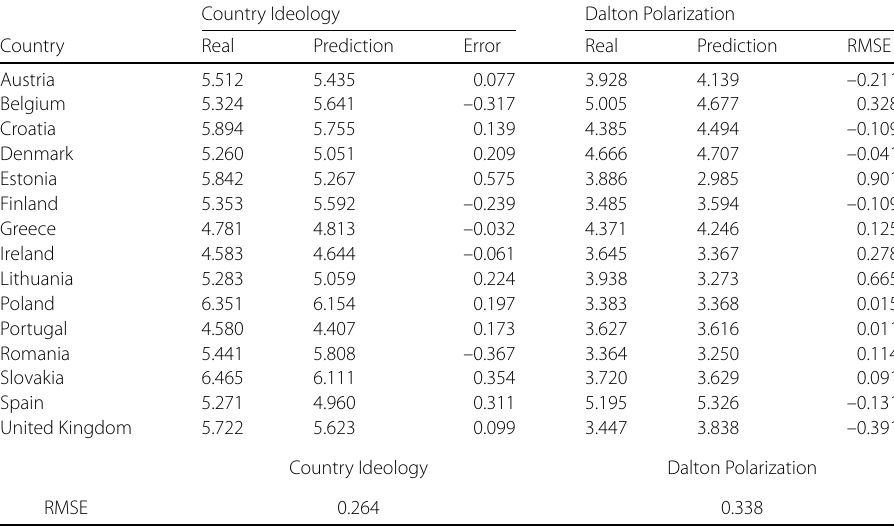
Table 9 Lasso Regression results for parliamentary elections in 2019-2020 Country Ideology Dalton Polarization Country Real Prediction Error Real Prediction RMSE